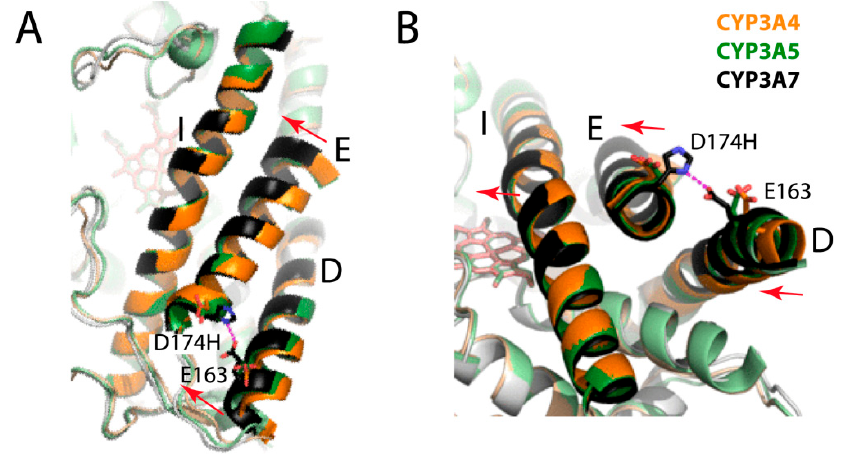
Figure 6. Top ( A ) and side views ( B ) on the I-E-D-helix bundle in CYP3A4 (5vcc), CYP3A5 (6mjm), and CYP3A7 (molecule A). In CYP3A7, there are helical shifts (indicated by arrows) and the newly formed H-bond between E163 and H174 (dotted line) that stabilizes the more compact and less stretchable conformation.